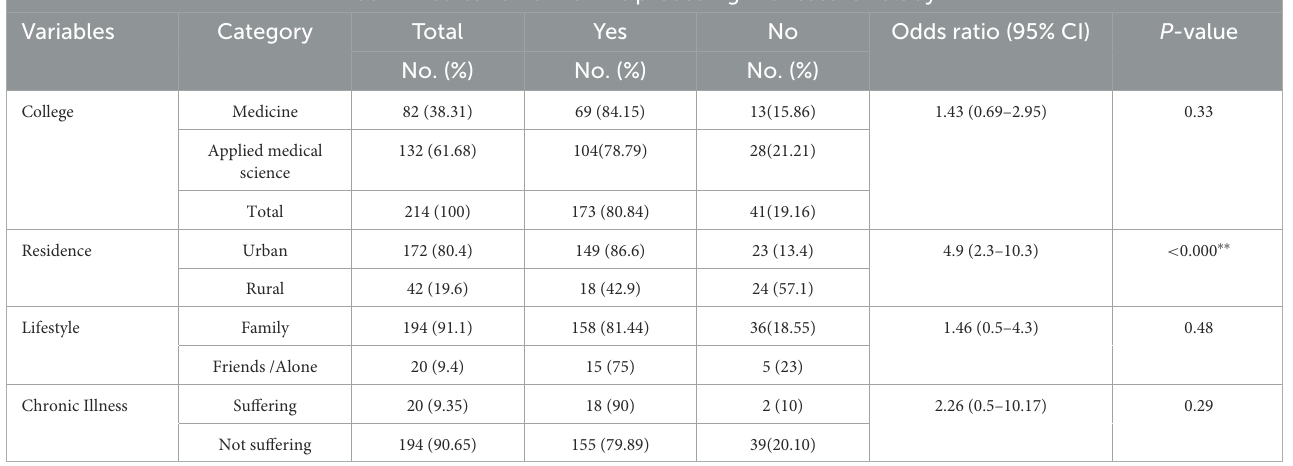
TABLE 1 Socio-demographic distribution among female participants ( N =